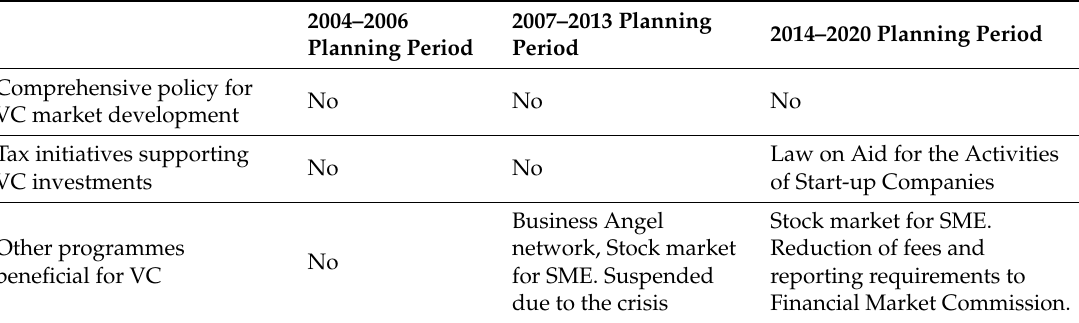
Table 7. Governmental activities to promote VC